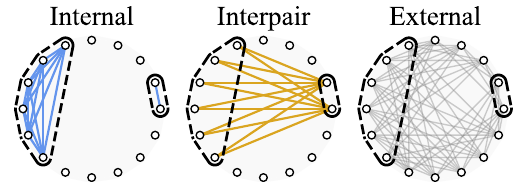
Fig. 6 Definition of internal, interpair and external edges for a pair of